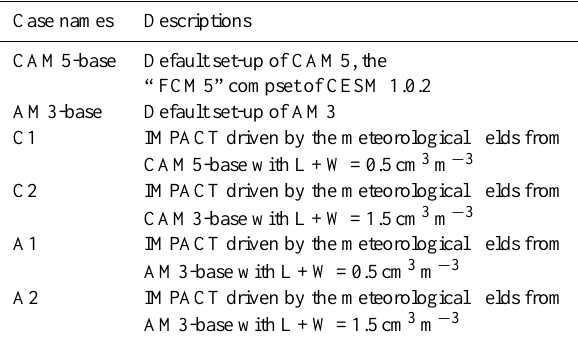
Table 2. Description of